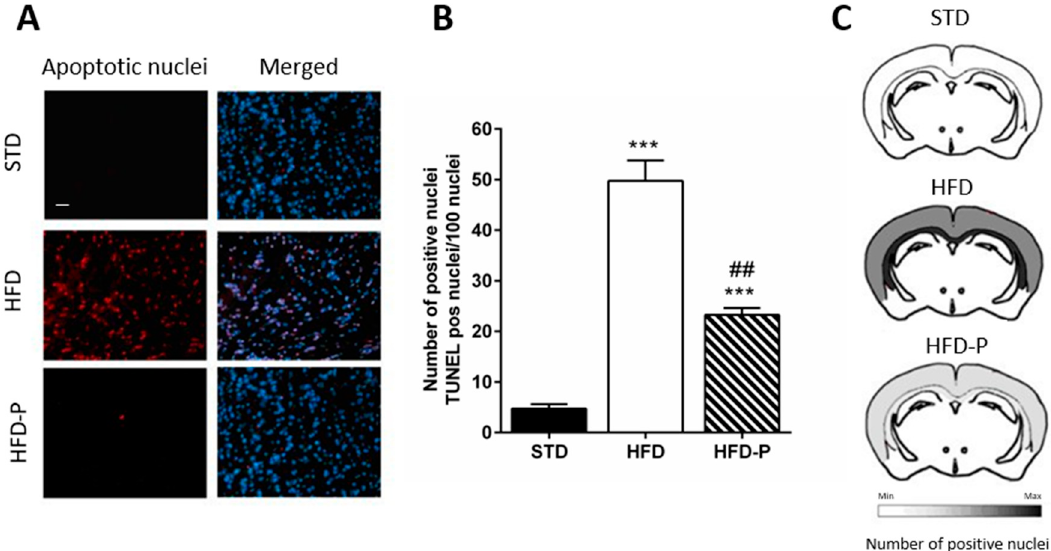
Figure 2. Pistachio consumption exerts a neuroprotective e ff ect. ( A ) TUNEL assay on cerebral cortex sections of STD, HFD, and HFD-P mice; ( B ) the number of apoptotic nuclei in the cerebral cortex; ( C ) scheme of distribution of positive TUNEL nuclei. Data are means ± SEM ( n = 8 / group). *** p < 0.001 vs STD, ## p < 0.01 vs HFD. Microscope magnification 20 × . Bar: 100 µ